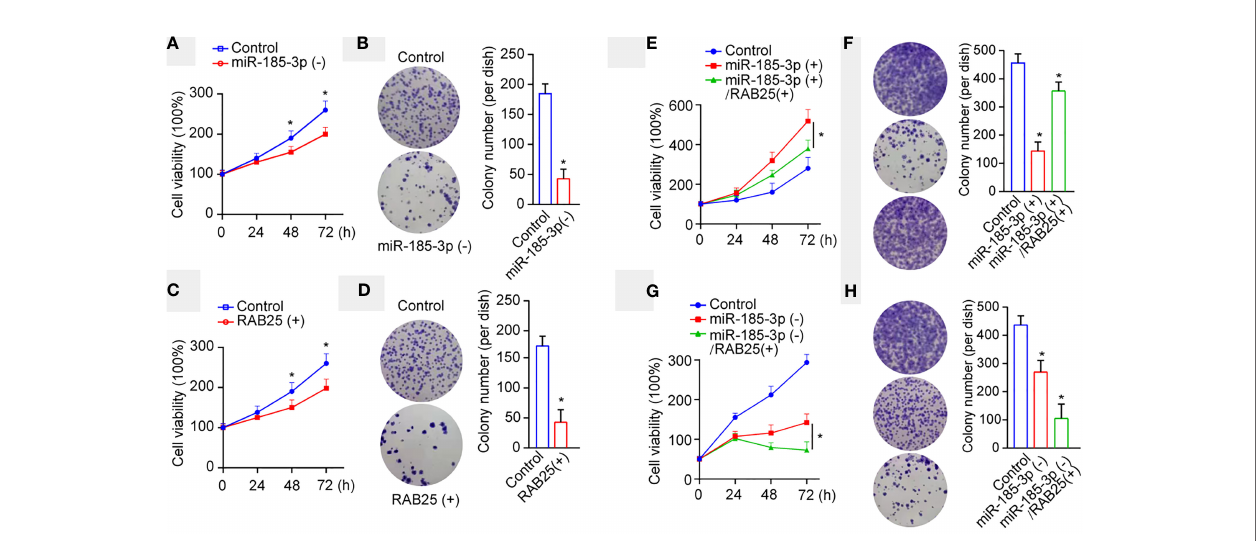
FIGURE 4 | miR-185-3p/RAB25 mediates tumor cell proliferation and colony formation. (A) Cell viability of HN4 with miR-185-3p knockdown or WT HN4 cells. (B) Cell colony number of HN4 with miR-185-3p knockdown or WT HN4 cells. (C) Cell viability of HN4 with RAB25 overexpression or WT HN4 cells. (D) Cell colony number of HN4 with RAB25 overexpression or WT HN4 cells. (E) Cell viability of HN4 with miR-185-3p overexpression, miR-185-3p/RAB25 overexpression, or WT HN4 cells. (F) Cell colony number of HN4 with miR-185-3p overexpression, miR-185-3p/RAB25 overexpression, or WT HN4 cells. (G) Cell viability of HN4 with